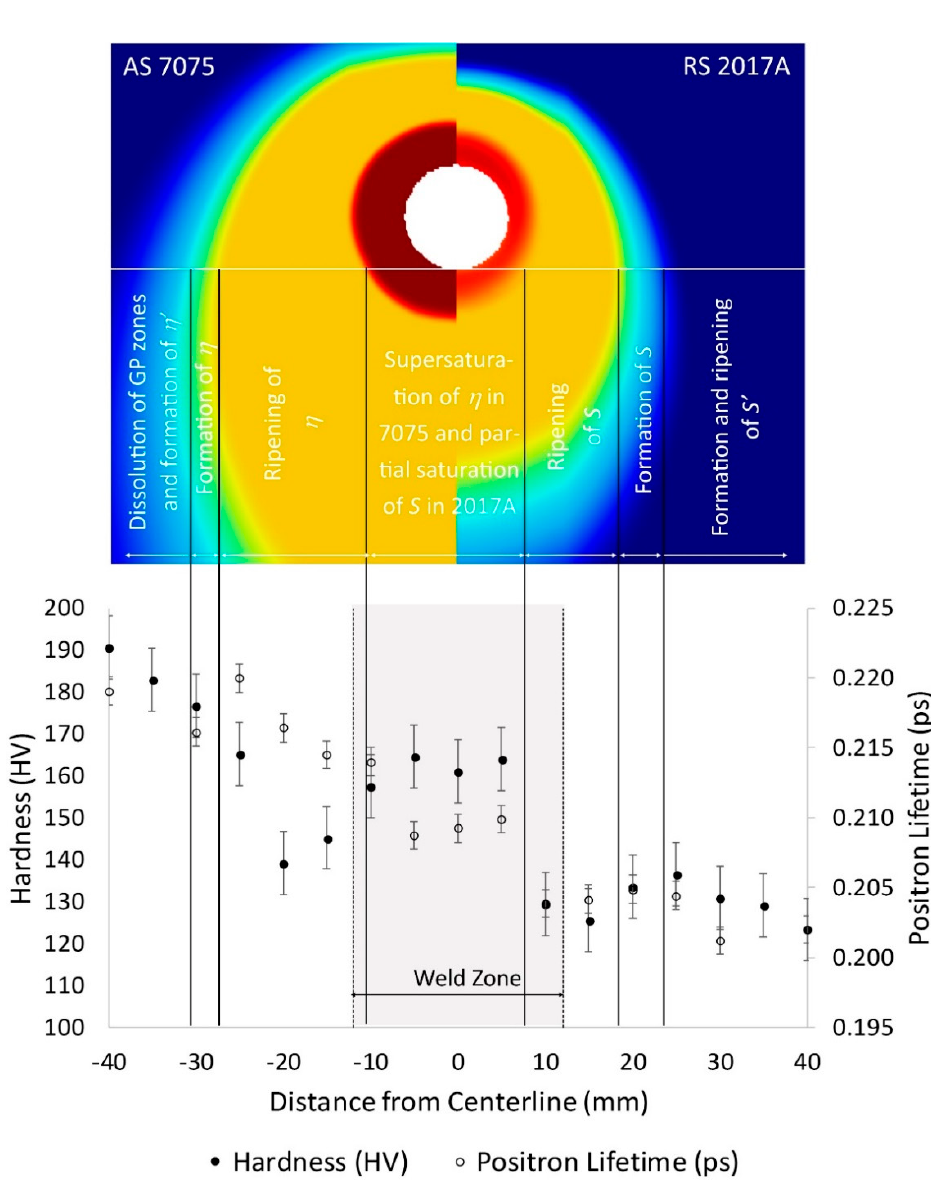
Figure 8. Phase transformation maps overlaid on lifetime/hardness profiles for the AS 7075/RS 2017A configuration. Boundaries between phase transformation regions align with transition areas in both hardness and positron lifetime.